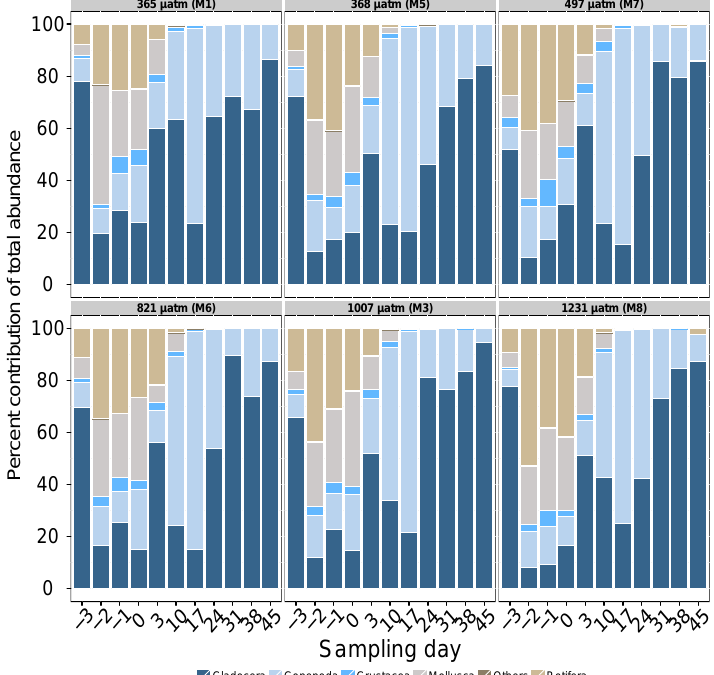
Figure 6. Percent contribution of mesozooplankton main taxonomic groups.